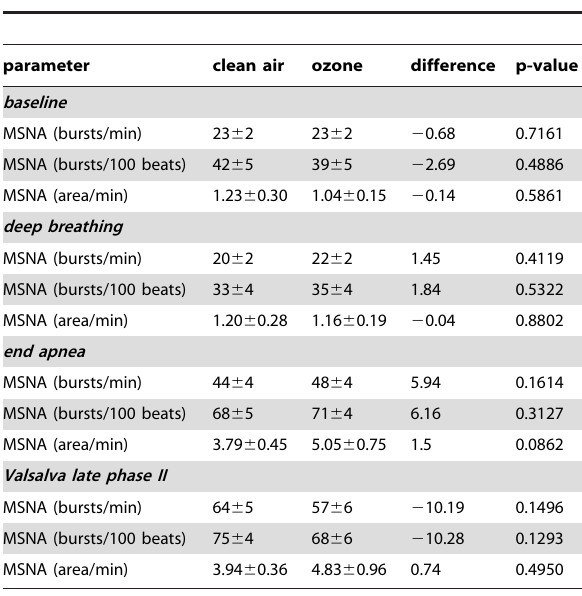
Table 3. Muscle sympathetic nerve activity (burst frequency, burst incidence and area under the burst) measured on both study days at rest, during deep breathing (6 breaths per minute), at the end of the maximum voluntary inspiratory breath hold maneuver (end apnea) and during late phase II of the Valsalva maneuver.